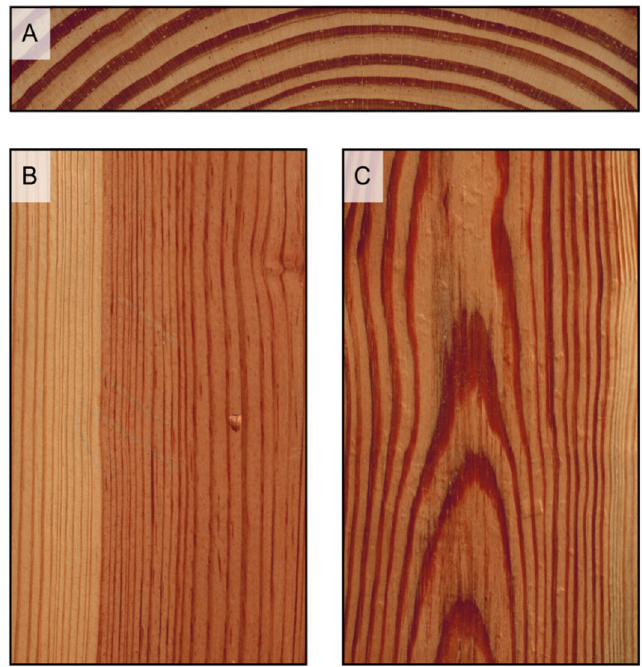
Figure 4. Growth rings appear as concentric circles on transverse surfaces (( A ), Pinus echinata ), as parallel bands on radial surfaces (( B ), Pinus rigida ), and as hyperbola branches, or flames, on longitudinal tangential surfaces (( C ), Pinus taeda ).